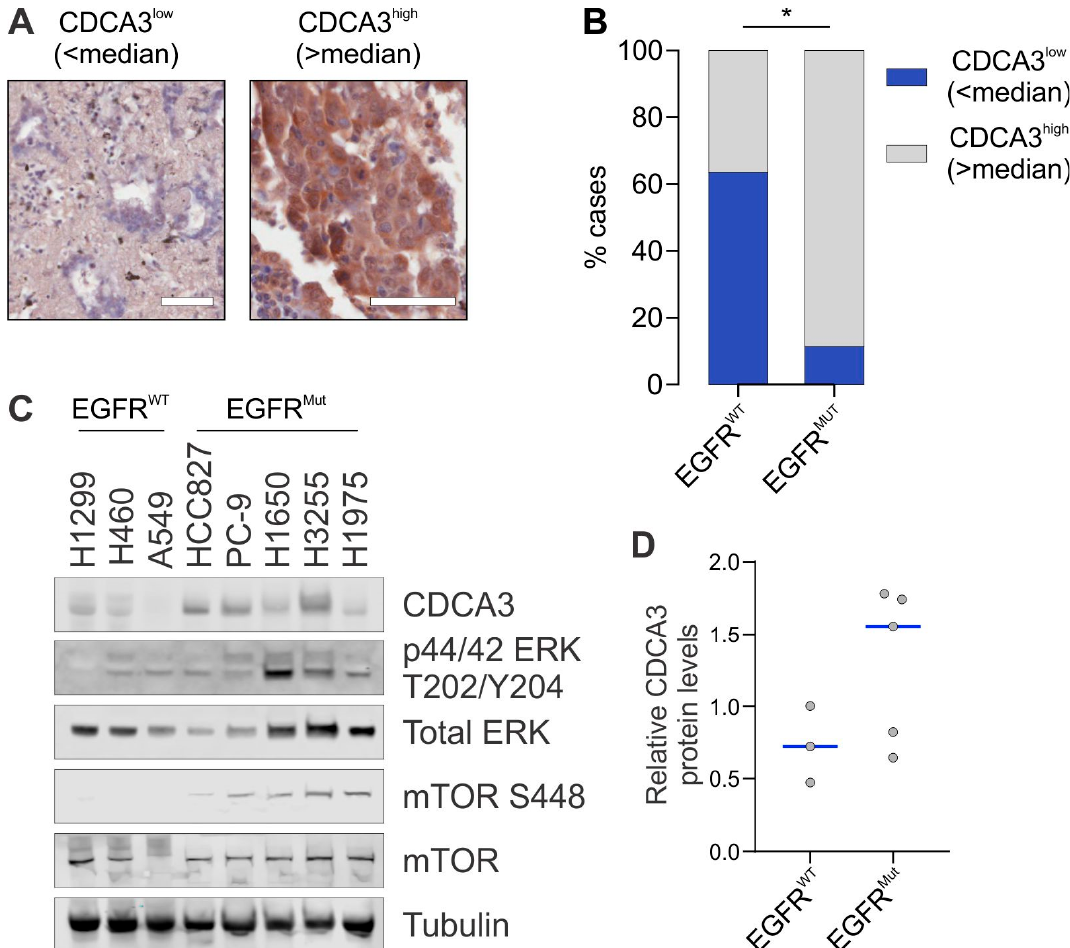
Figure 1. CDCA3 protein is upregulated in EGFR mutant NSCLC. ( A ) Representative images of CDCA3 low (left panel) and CDCA3 high (right panel) staining by immunohistochemistry in NSCLC cohort. CDCA3 levels determined by stratifying on median H-score. Scale bar = 50 µm. ( B ) Stacked bar chart showing distribution of CDCA3 low (blue) and CDCA3 high (grey) levels quantified from immunohistochemistry staining of non-oncogene-driven NSCLC (EGFR-WT) cases and EGFR mutant cases (chi-square test, * p = 0.02). ( C ) Representative endogenous CDCA3 Western blot analysis from lysates of NSCLC adenocarcinoma cell lines evaluating a small panel of non-oncogene-driven (EGFR WT) and EGFR mutant (EGFR MUT) cell lines. Phosphorylated and total ERK and mTOR Western blot analysis to assess constitutive signalling in EGFR mutant cell lines. Tubulin used as a loading control. ( D ) Densitometry quantification of ( C ), with dot points representing relative CDCA3 levels from three independent experiments. Blue lines indicate median